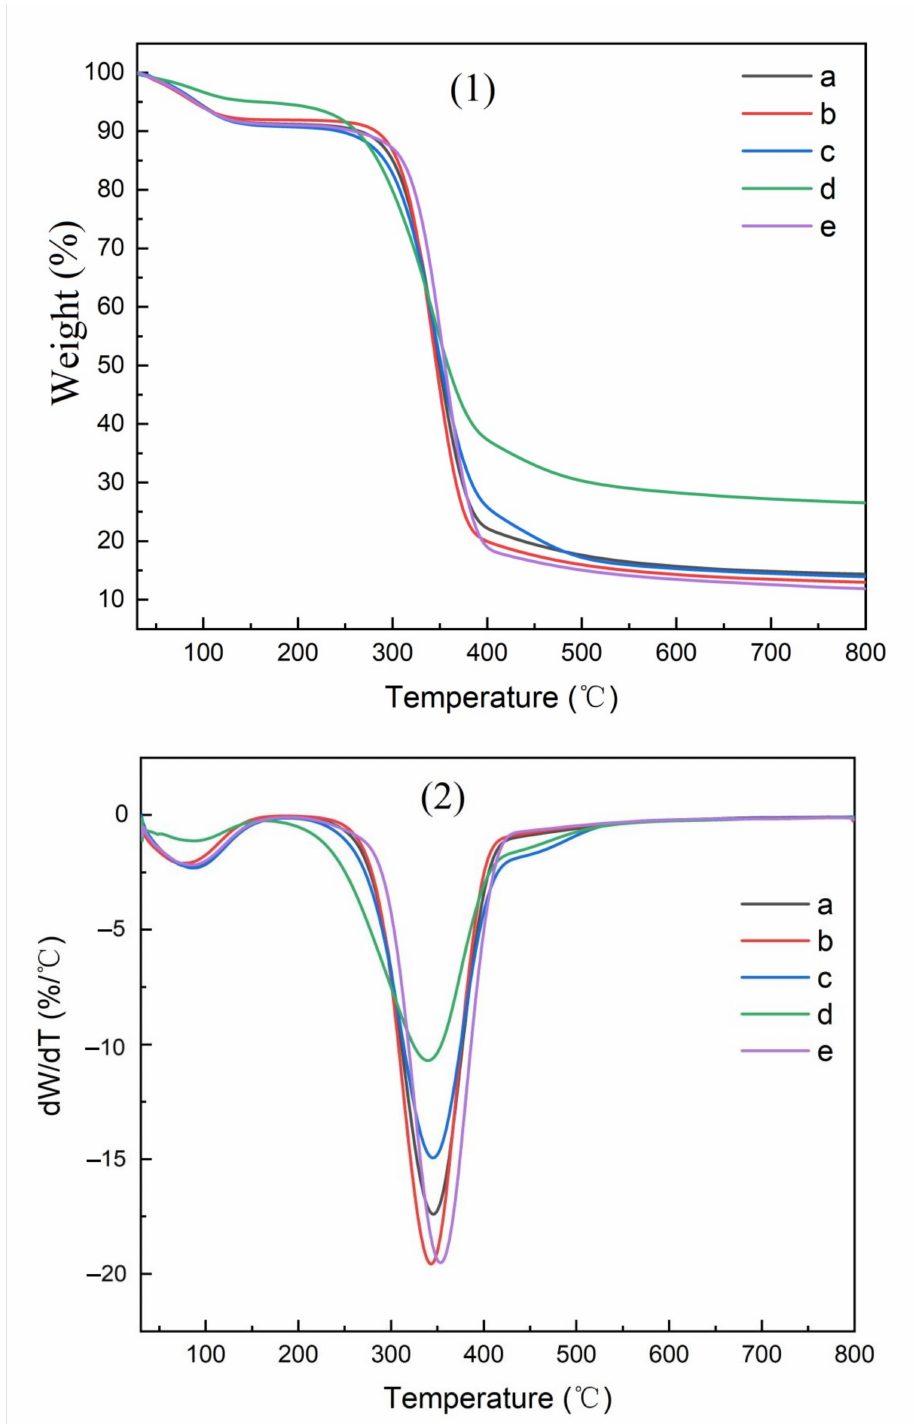
Figure 11. TG curves of cellulose derived from (a) pine wood, (b) bamboo culm, (c) pine needles, (d), bamboo leaves, or (e) hemp hurd, shown as thermogravimetric analysis ( 1 ) or differential thermogravimetric analysis ( 2